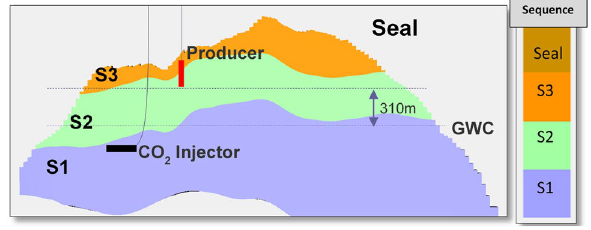
Fig. 1 Reservoir architecture of the proposed gas